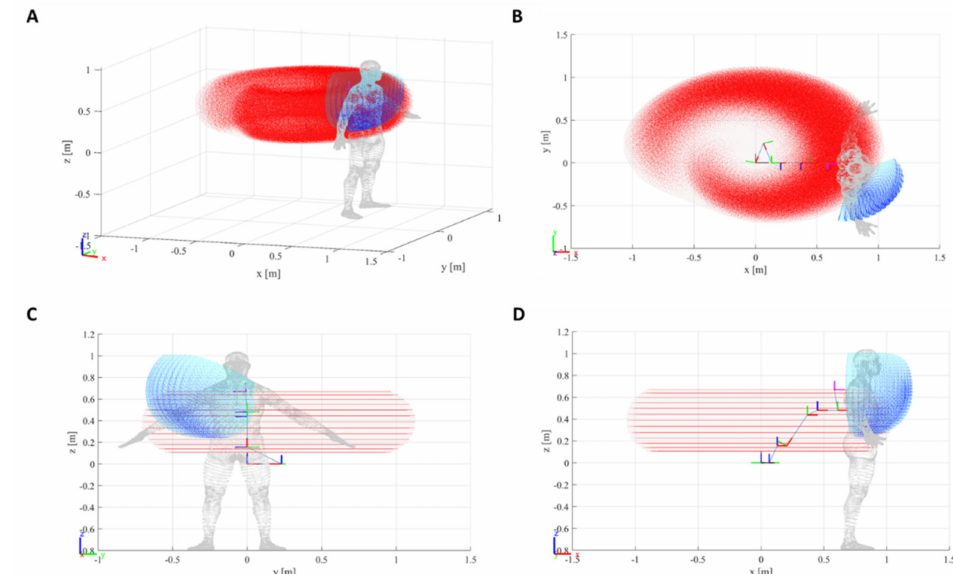
Figure 12. Float exoskeleton cloud point of the end-effector (elbow) from different angles (blue dots). Passive polyarticulated arm cloud point in red. The combination of the two cloud points results in a large workspace allowing 3D movements. ( A – D ) offer different view angles of the same cloud